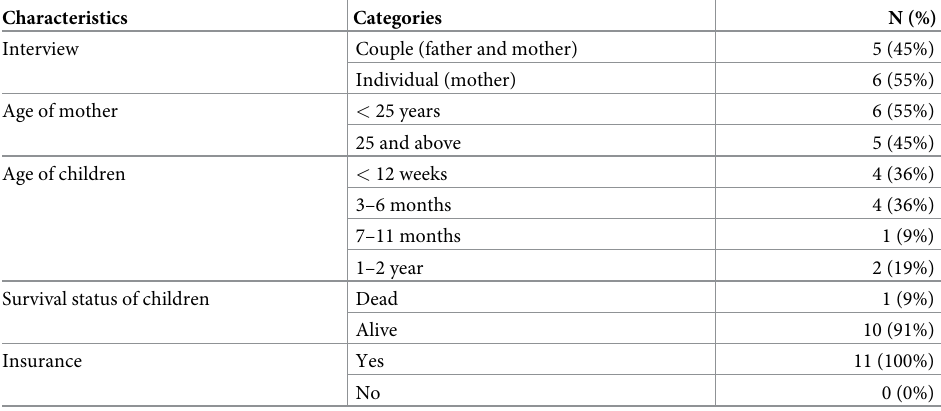
Table 1. Sociodemographic characteristics of the